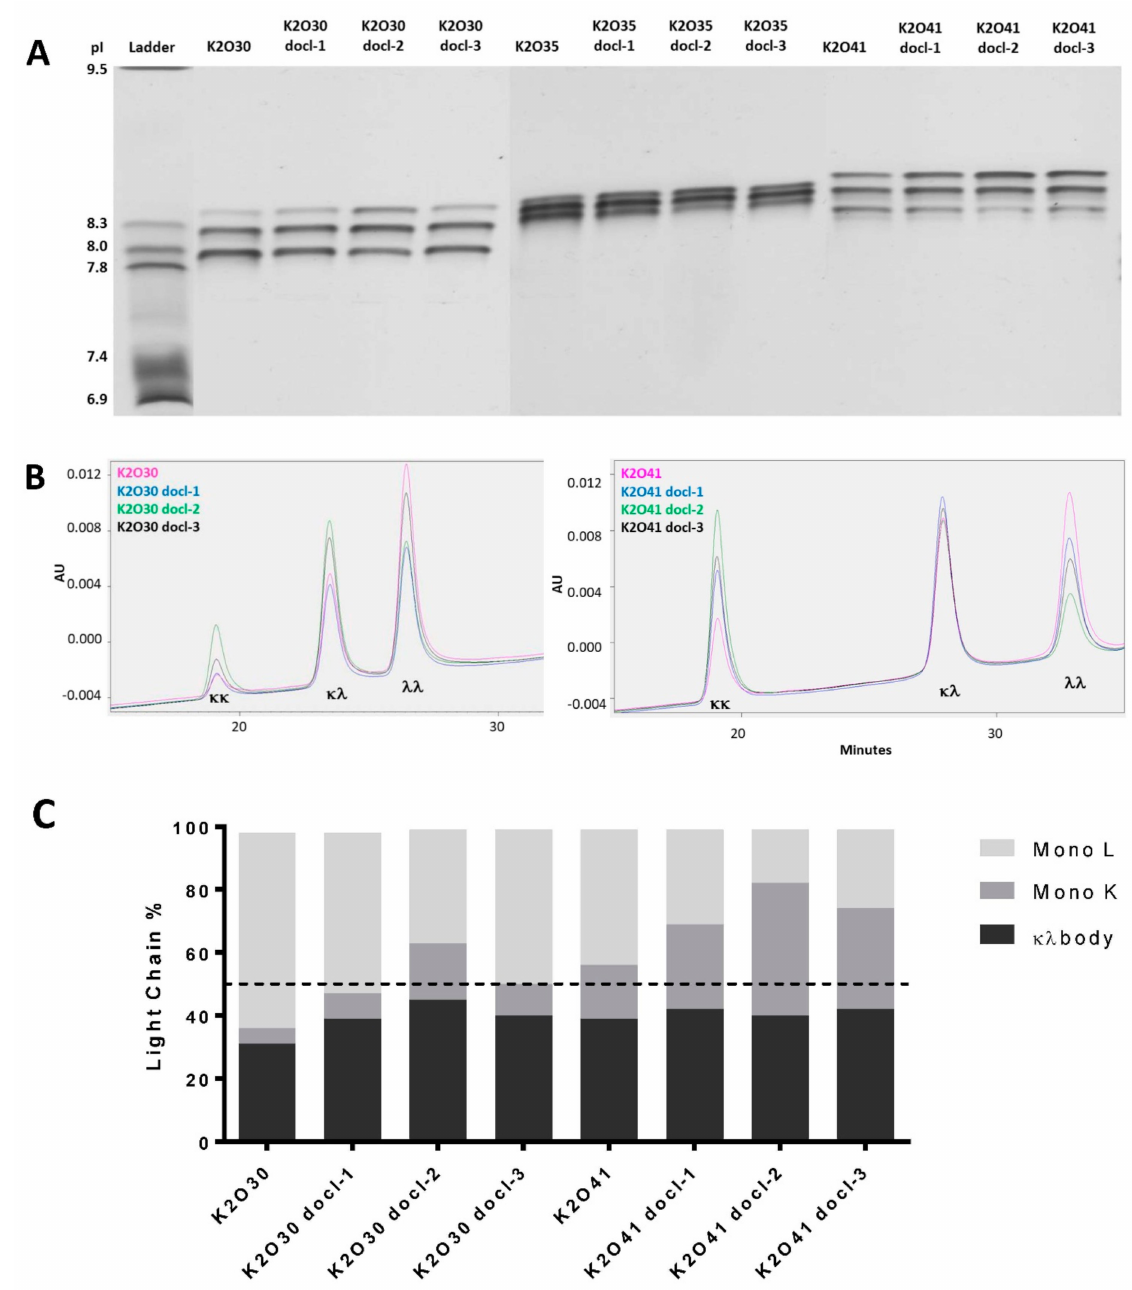
Figure 2. IgG expression after transfection in PEAK cells of K2O30, K2O35, K2O41 and their respective codon de-optimized variants. ( A ) Isoelectric focusing analysis of the purified total IgG samples; the top and bottom bands represent the IgG κκ and the IgG λλ , respectively, the intermediate band corresponds to the IgG κλ ( κλ body). ( B ) Analysis by hydrophobic interaction high performance liquid chromatography (HIC-HPLC) of purified total IgG for K2O30, K2O41 and their respective codon de-optimized variants. Peaks corresponding to each of the three forms are indicated. ( C ) Distribution of the three IgG forms analyzed by HIC-HPLC. pI: Isoelectric Point. AU: area under the